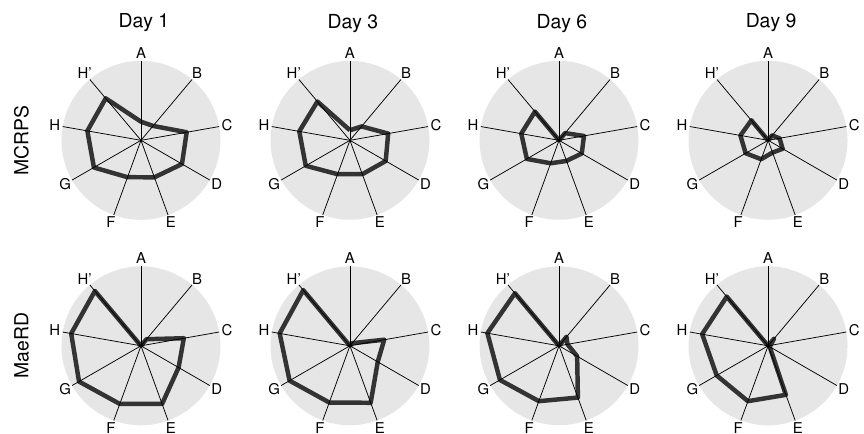
Figure 2. Synthetic results of the nine systems that are referred by their code letter (see Table 3). The four top radar plots illustrate the MCRPS with the center indicating the climatology reference performance, and the perimeter representing a perfectly accurate simulation. The four bottom plots describe the measure of distance from perfect reliability, with the center indicating a MaeRD = 0.5 while the perimeter corresponds to a perfect